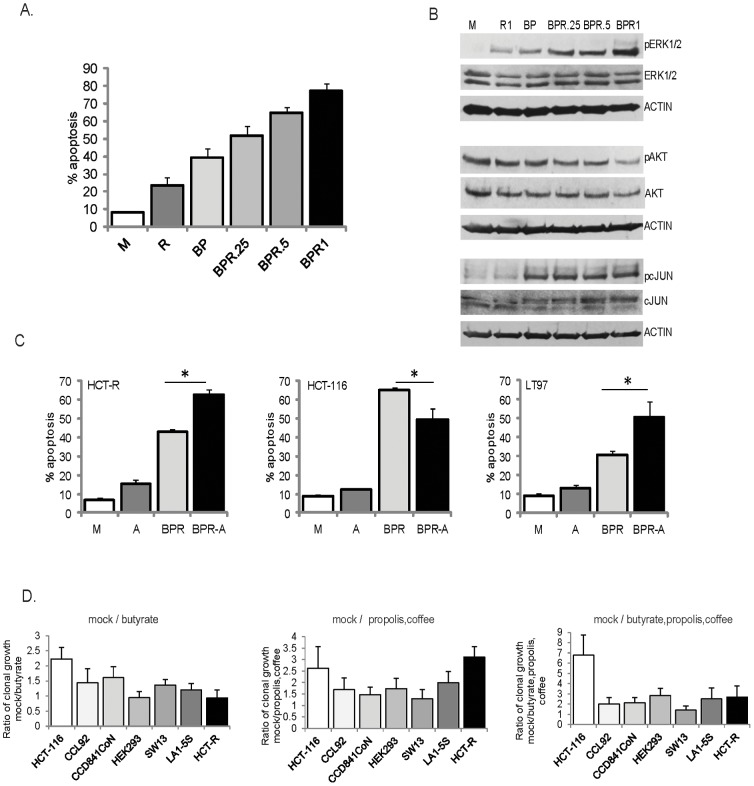
Role for ERK signaling in the apoptosis of CRC cells exposed to dietary agents and clonal growth ability of neoplastic and normal cells exposed to such agents.A. HCT116 cells were exposed for 24 h to mock (M), 1 mg/ml roasted coffee extract (R), 5 mM butyrate and 100 µg/ml propolis (BP), or butyrate/propolis and increasing concentrations of coffee extract: 0.25, 0.5 or 1.0 mg/ml. Apoptosis was measured by flow cytometry as described in Materials and Methods. B. HCT-116 cells were treated as in (A) for 17 hours and total cell lysates were analyzed by western blotting. C. HCT-116 and LT 97 cells were exposed for 20 h, and HCT-R cells were exposed for 42 h to mock (M), 0.5 µM AZD6244 (A), the combination; 5 mM butyrate, 100 µg/ml propolis, 1 mg/ml roasted coffee extract (BPR), or BPR and 0.5 µM AZD6244 (BPR-A). Apoptosis was measured by flow cytometry, as described in Materials and Methods. Statistically significant differences in apoptotic levels are noted by asterisks (P<0.05). D. Clonal growth assays. Percent clonal growth was calculated by dividing the number of cell colonies by the number of plated cells, and multiplying by 100. The ratios of clonal growth were calculated by dividing the percent clonal growth in mock-treated samples by the percent clonal growth in agent-treated samples. Experiments were repeated four to six times with triplicate samples per experiment. Statistically significant differences among cell lines in their mean ratios were determined by one-way ANOVA. For cells exposed to butyrate, F(6,31) = 10.26, P<0.0001; for cells exposed to propolis and coffee extract, F(6,28) = 5.493, P = 0.0007, and for cells exposed to butyrate, propolis and coffee extract, F(6,26) = 10.56, P<0.0001. The post-test calculations used the Bonferroni correction to adjust for multiple comparisons with 95% confidence. Among the cells exposed to butyrate, statistically significant differences (P<0.05, CI 95%) were detected in HCT116 vs. CCL92, HCT116 vs. HEK293, HCT116 vs. SW13, HCT116 vs. LA1-5s, HCT116 vs. HCT-R, CCD841CoN vs. HEK293, and CCD841CoN vs. HCT-R cells. Among the cell lines exposed to propolis and coffee extract, statistically significant differences (P<0.05, CI 95%) were detected in HCT116 vs. SW13, HCT-R vs. CCL92, CCD841CoN vs. HCT-R cells, HEK293 vs. HCT-R, and SW13 vs. HCT-R cells. Among cell lines exposed to butyrate, propolis, and coffee extract statistically significant differences (P<0.05, CI 95%) were detected in HEK293 vs. SW13 cells, and HCT116 vs. all other cell lines except for HCT-R cell line.